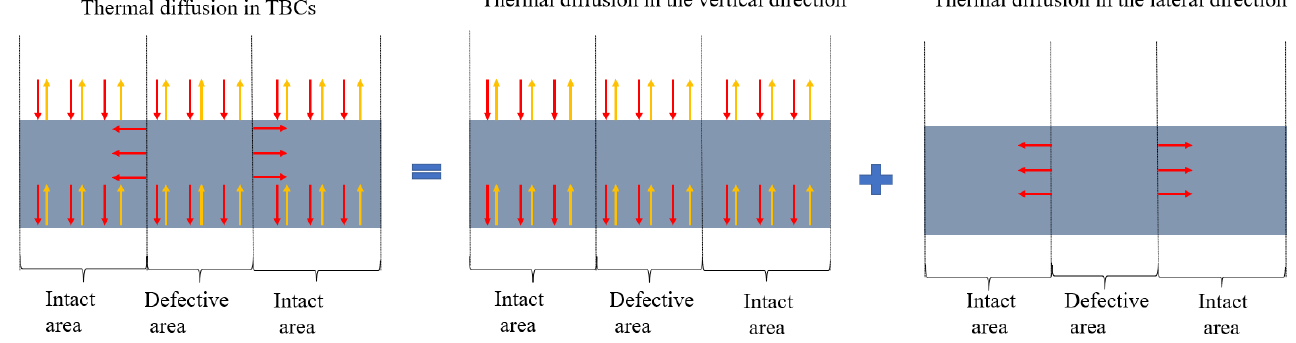
Figure 8. Schematic diagram of thermal diffusion in TBCs with interfacial defect.